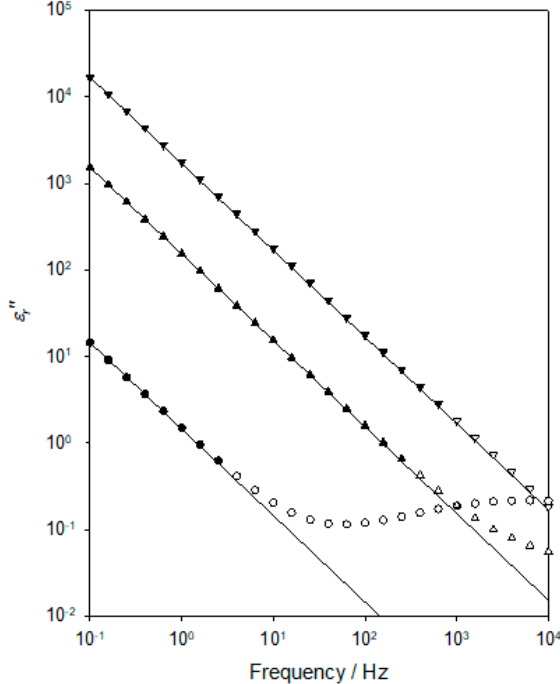
Figure 8. Representative data showing the frequency dependence of ε r ′′ at selected temperatures in the range from 273 K to 373 K. Measured ε r ′′ data obtained at 273 K ( ); truncated ε r ′′ data at 273 K ( ) used to determine the indicated fit line. Measured ε r ′′ data obtained at 323 K ( ); truncated ε r ′′ data at 273 K ( ) used to determine the indicated fit line. Measured ε r ′′ data obtained at 373 K ( ); truncated ε r ′′ data at 273 K ( ) used to determine the indicated fit lines.